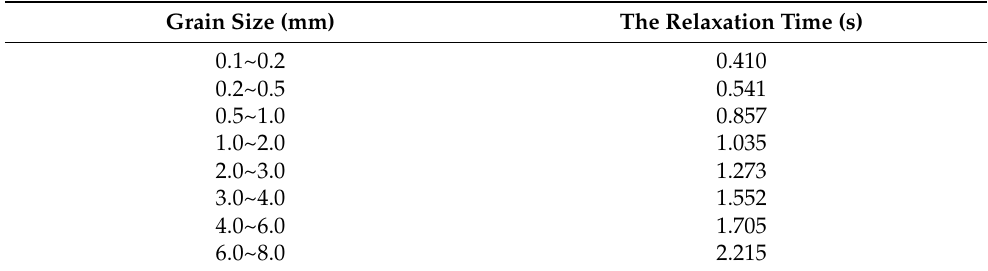
Table 1. Relaxation time of sand samples.